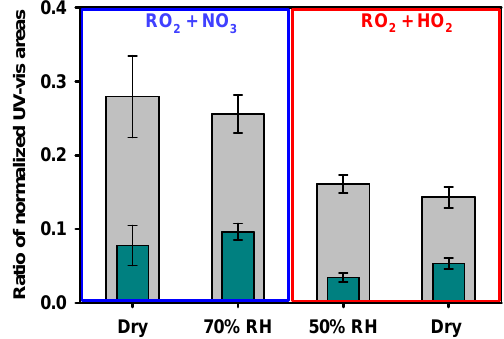
Figure 9. Ratio of the total areas integrated under UV–visible chro- matograms collected at 235nm (gray bars; ROOR and ROOH) and 270nm (teal bars; -C = O and -ONO 2 ) relative to 205nm for experi- ments dominated by (left-hand side panel) RO 2 + NO 3 reaction and (right-hand side panel) RO 2 + HO 2 reaction under both humid and dry